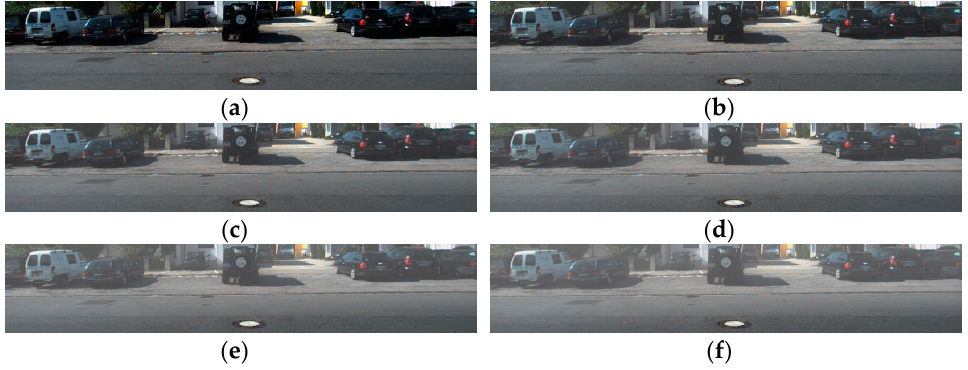
Figure 10. Synthetic image generated from difference of scattering coefficient: ( a ) β = 0; ( b ) β = 0.001; ( c ) β = 0.0015; ( d ) β = 0.002; ( e ) β = 0.0025; ( f ) β = 0.003.